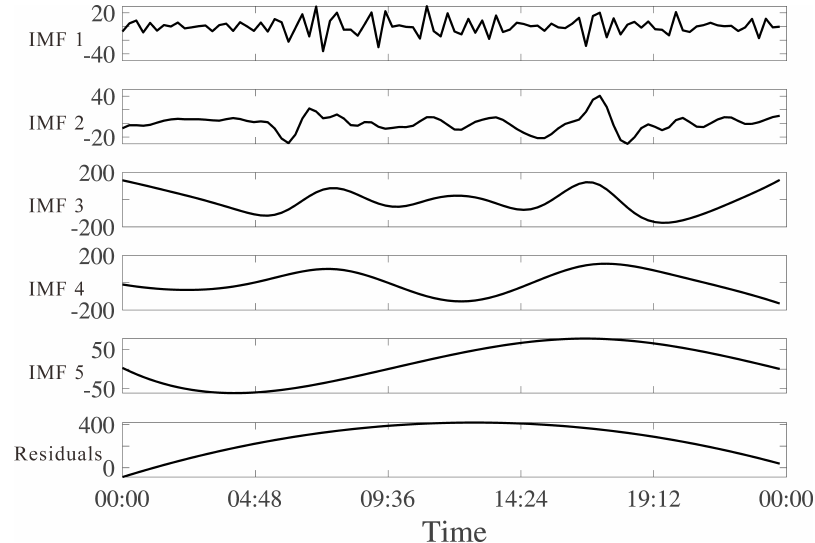
Figure 9. Decomposition of the original signal by the ensemble empirical mode decomposition